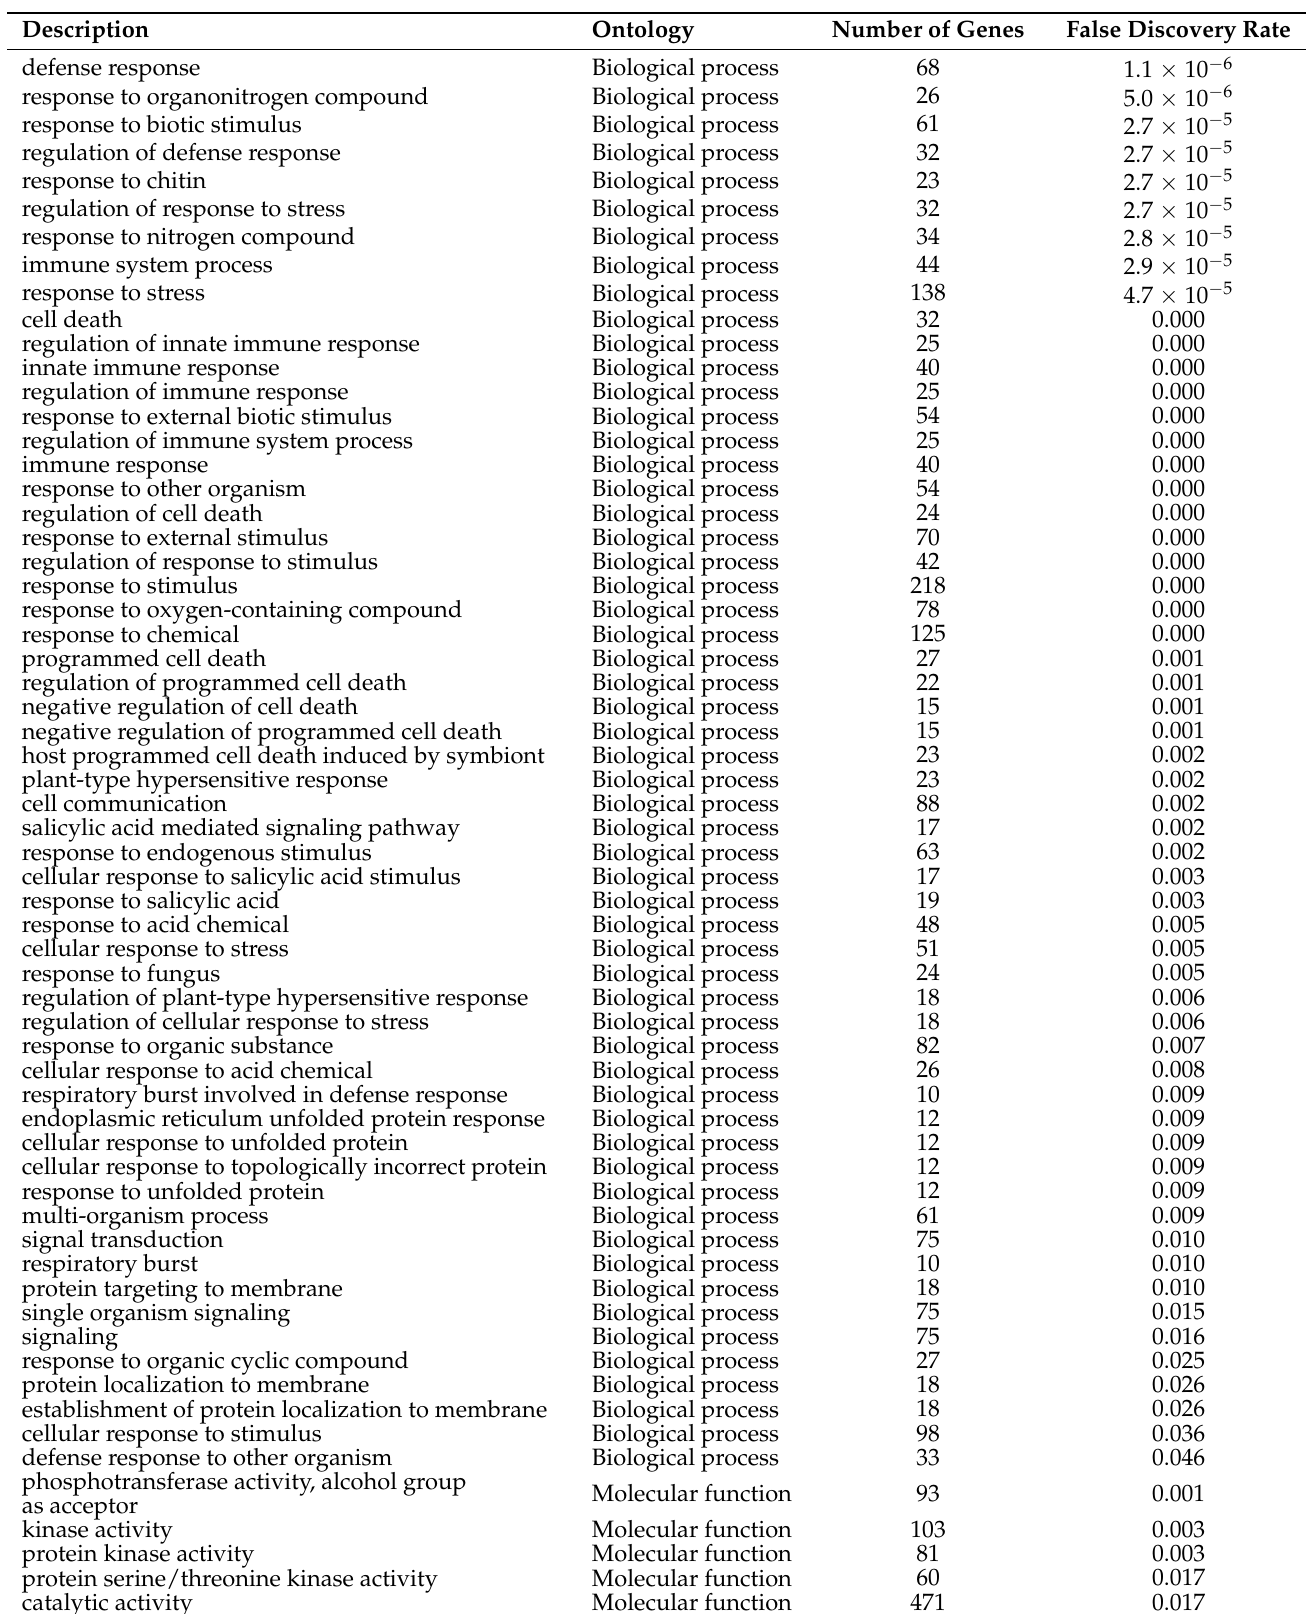
Table 3. GO terms enriched in YZ during infection by B.